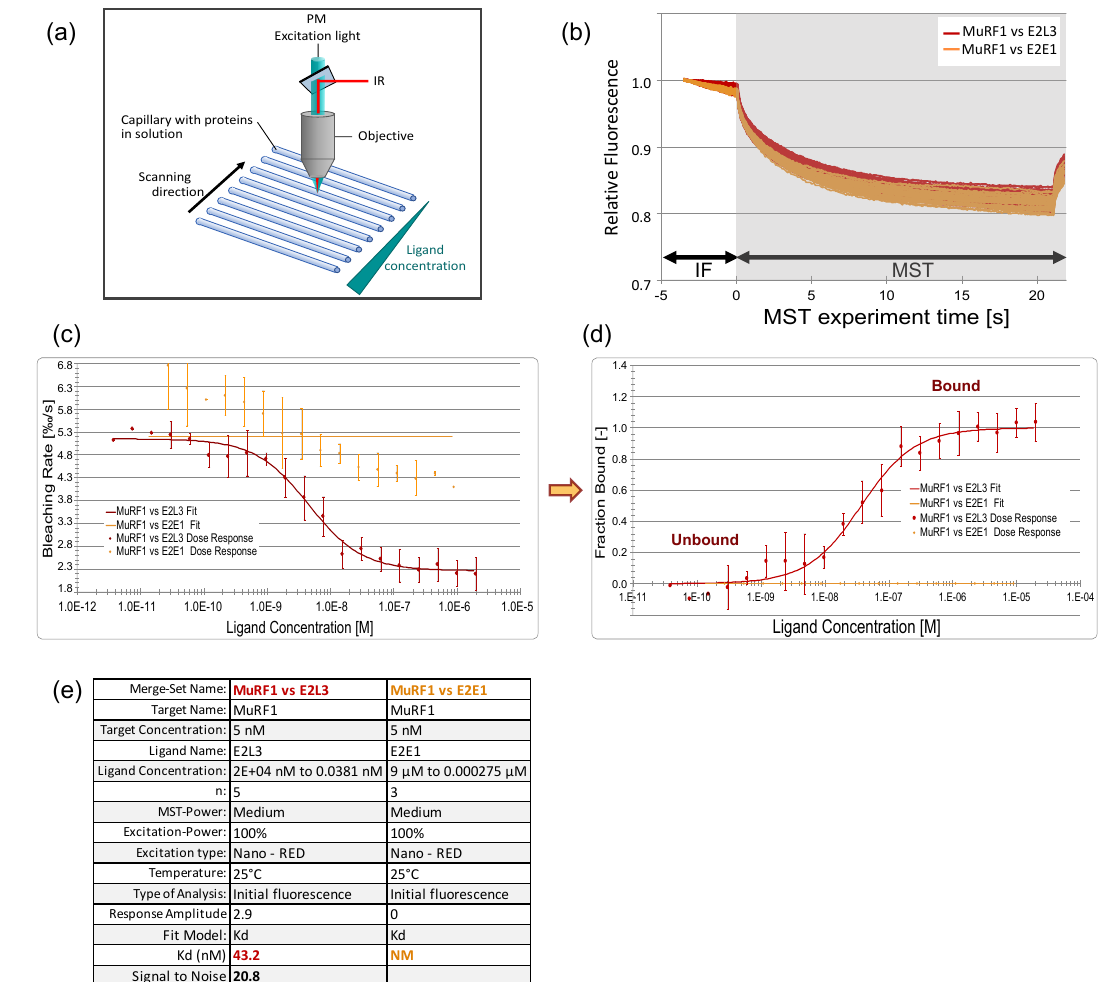
Figure 3. MuRF1–E2L3 affinity determination, using photobleaching rate. ( a ) Principle of the Monolith (adapted from Reference [50]). A fluorescent protein in solution in capillaries is excited with a UV LED; the fluorescence is recorded by a photomultiplier (PM) and plotted against time to get an MST (MicroScale-Thermophoresis) trace chart. ( b ) The fluorescent NT647–MuRF1 was mixed with the putative partner subjected to a 16-sample serial dilution. Variation of MuRF1 fluorescence was followed over time, in the presence of E2s; E2L3 (red), an interacting E2, and E2E1 (orange), a non-interacting E2 in this condition. When ligand binding changes the photobleaching properties of the fluorescent target, which is visible by the decrease in the initial fluorescence (IF) zone of the graph (t = − 5 to 0 sec, before the Infra-Red (IR) laser was switched on), photobleaching rate has to be used for calculation of the affinity, instead of MST. ( c ) Dose–response curves are expressed in bleaching rate and plotted against E2s concentrations. ( d ) Transformation of dose–response curves from ( c ), in fraction bound for easier comparison between curves. ( e ) Dataset overview; n, number of replicates; NM, not measurable. A signal-to-noise >10 indicates a reliable